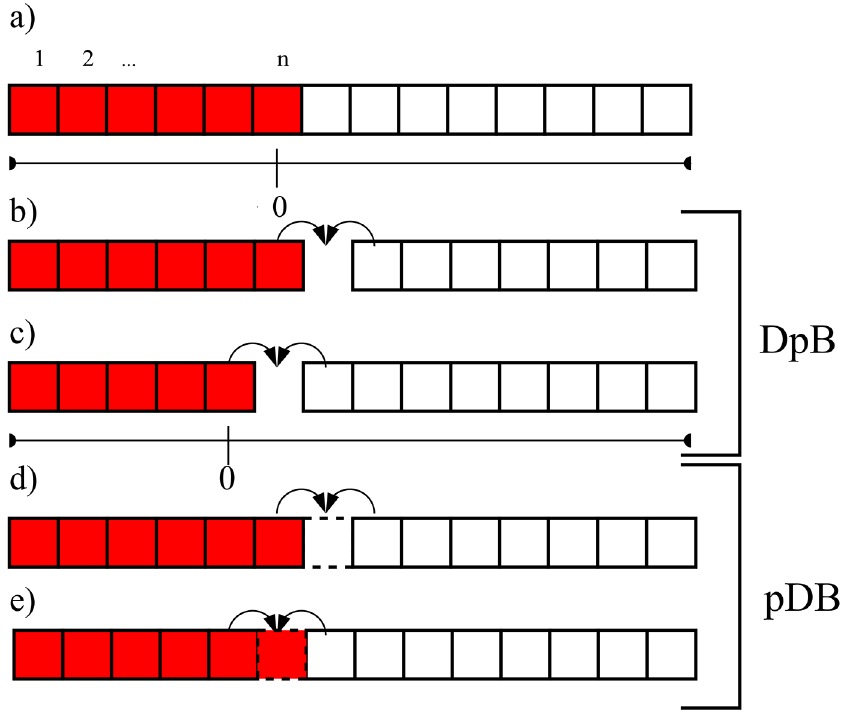
Figure 1. The initial distributions of P (red) and NP (white) cells with a P array being n cell long (a) and the possible invasion events at the border of arrays if DpB update rule (b, c) and if pDB update rule is assumed (d, e). For DpB update rule first a cell dies, then the concentration of the diffusive material is computed and finally reproduction occurs, for pDB update rule first the concentration of the diffusive material is calculated, then reproduction and finally death take place. Arrows indicate the nearest neighbors competing for the empty site. Origin is placed at the P cell being at the actual border of P and NP arrays as indicated in figure (c).